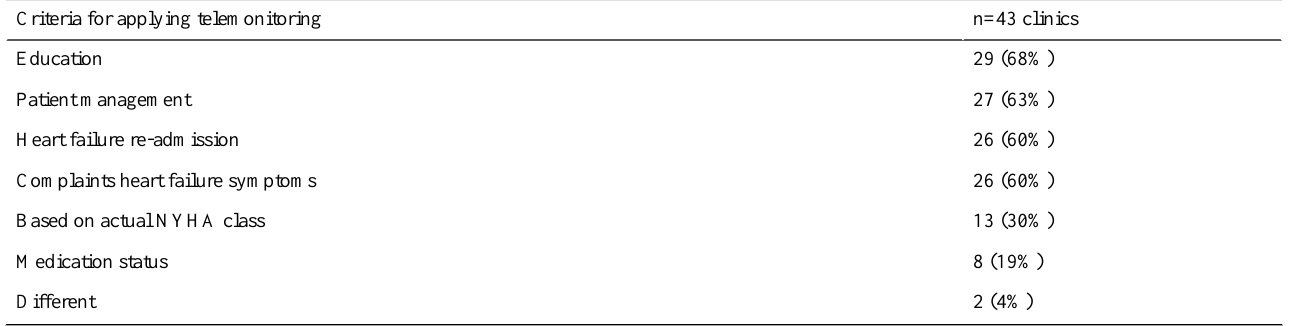
Table 4. Criteria for applying telemonitoring in heart failure (HF)